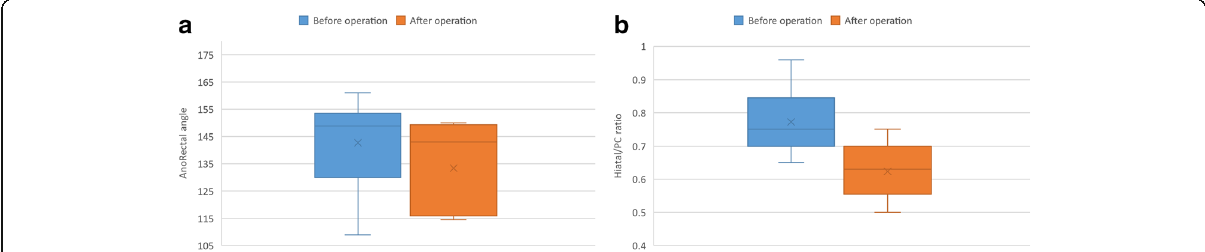
Fig. 5 Statistical analysis comparing pelvic MRI measurements (anorectal angle and hiatal/PC ratio) before and after reoperation. A favorable decrease in the values of anorectal angle and hiatal/PC ratio was detected (Wilcoxon signed rank test; p -values = 0.07 and 0.01,